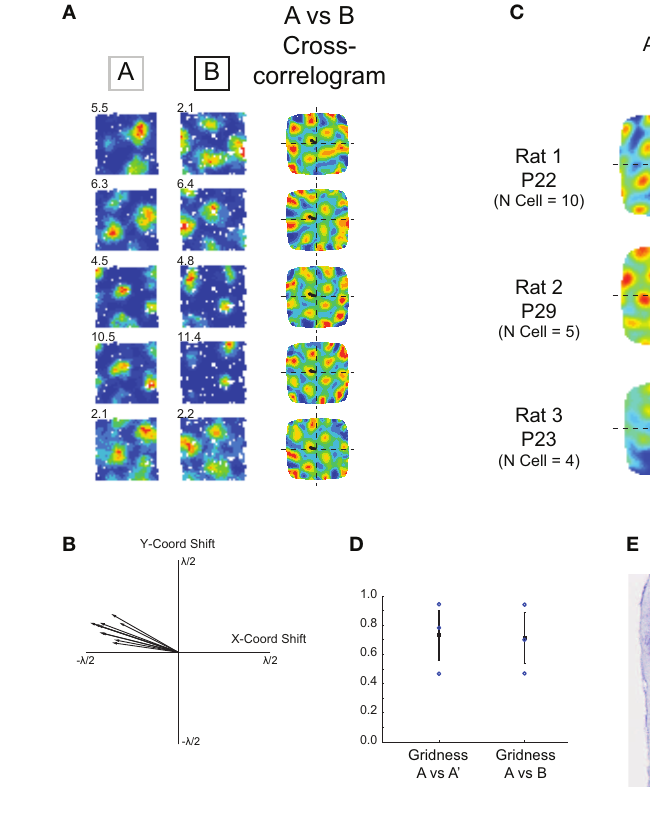
in two consecutive trials in the same environment. Middle column: population vector cross-correlogram for Env A versus Env B. Two ensembles (P29 and P23) show some degradation in the hexagonal symmetry. Right column: cross-correlogram after rotation of Env B rate maps. Hexagonal symmetry is restored in the P29 and P23 ensembles, demonstrating a coherent rotation of grid cell firing fields between Env A and Env B. (D) Gridness scores calculated from population vector cross-correlograms, for within-environment and across-environment comparisons. (E) Estimated recording locations for the three ensembles of simultaneously recorded cells. Ensembles from Rats 2 and 3 were most likely recorded from mEC LII, the ensemble from Rat 1 was most likely recorded from just below the mEC/Parasubiculum border zone. Scale bar =